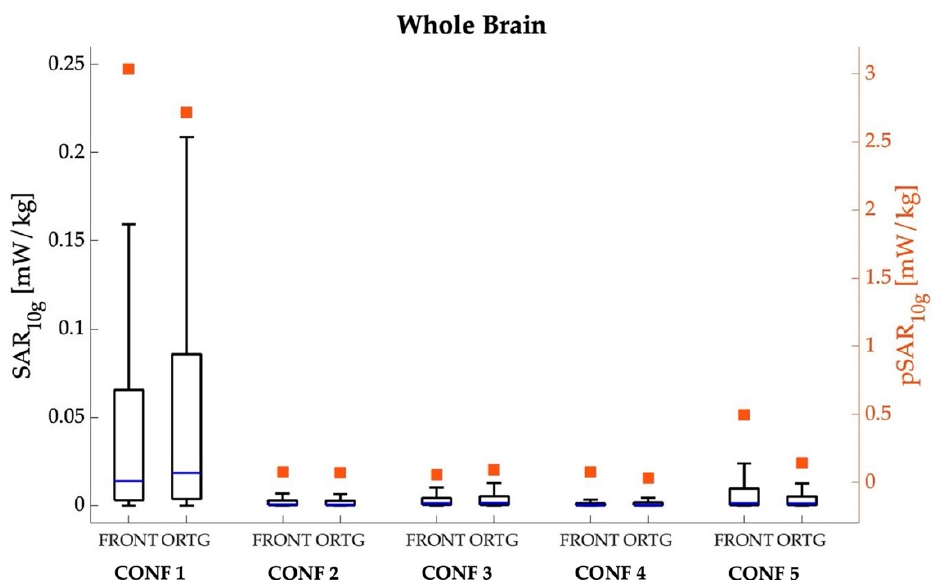
Figure 6. SAR 10g (left y -axis, box plot) and pSAR 10g (right y -axis, square symbols) in the brain tissue for the five different examined configurations, considering the frontal and orthogonal orientations of the Ella model. The center line in the boxes is the median; the bottom and top edges are the 25th and 75th percentiles. The lower whisker extends to the minimum value, while the upper whisker extends to 1.5 times the height of the box.